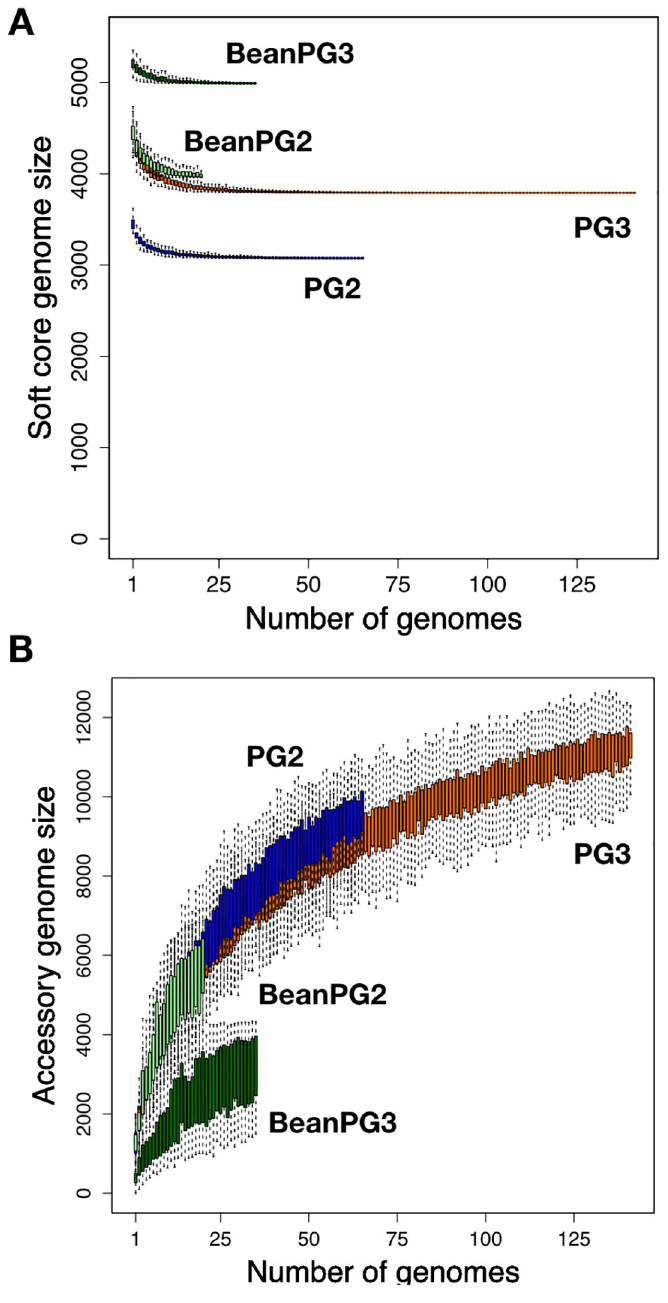
Fig 2. Rarefaction curves for the core and accessory genomes. Families present in 95% (soft core genome) of P . syringae isolates exponentially decay as each new genome is added to the analysis. The total number of gene families identified continues to increase indefinitely with the addition of new genomes when singletons (families only present in one isolate) are